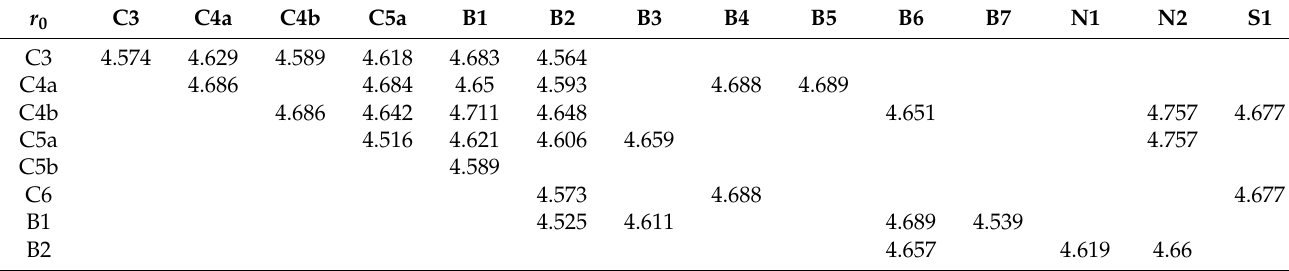
Table 6. Force field parameter r 0